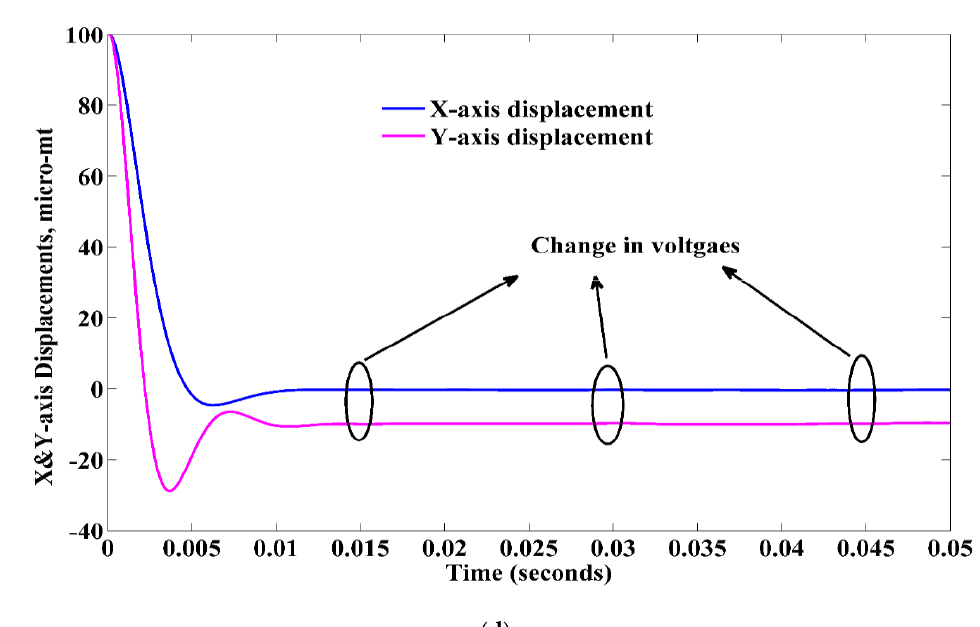
Figure 23. Suspension parameters under the changes in Applied Voltage. ( a ) Changes in suspension winding voltages; ( b ) Suspension force in the X direction when suspension voltage is changed; ( c ) Suspension force in the Y direction when suspension voltage is changed; ( d ) Rotor Xand Y-directional displacements when suspension voltage is changed.